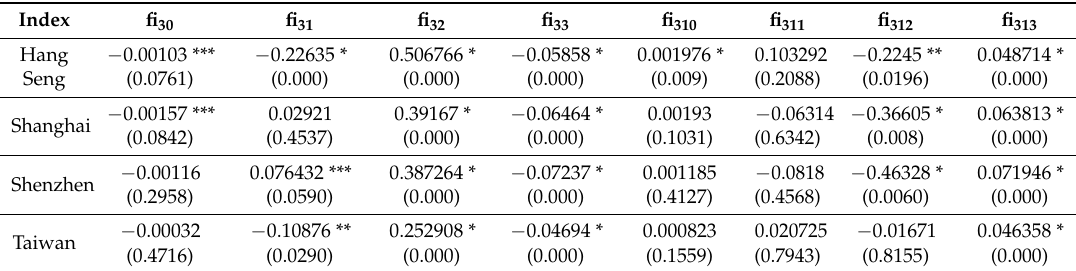
Table 6. Market Model